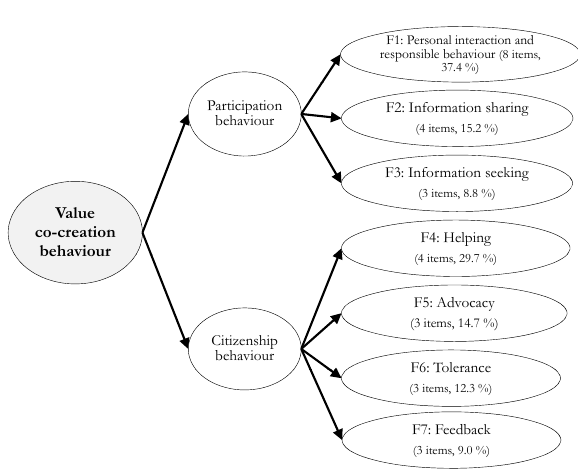
Fig. 4 – Dimensions of co-creation behaviour Source: own